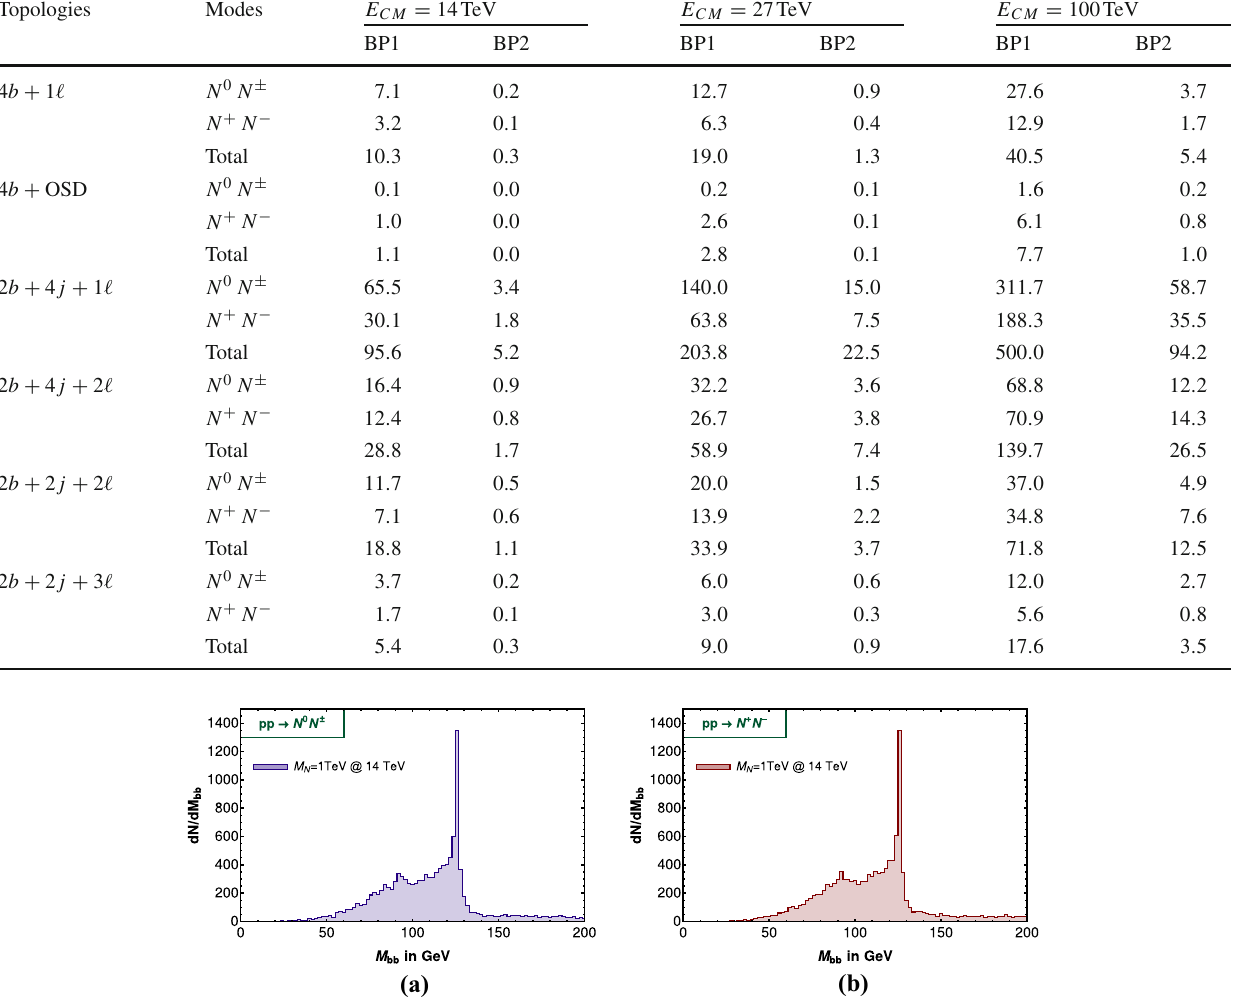
Table 7 Number of events for finalstate topologies containing at least two b -jets for the benchmark points with the centre of mass energies of 14 TeV, 27 TeV and 100 TeV at the LHC with integrated luminosi-